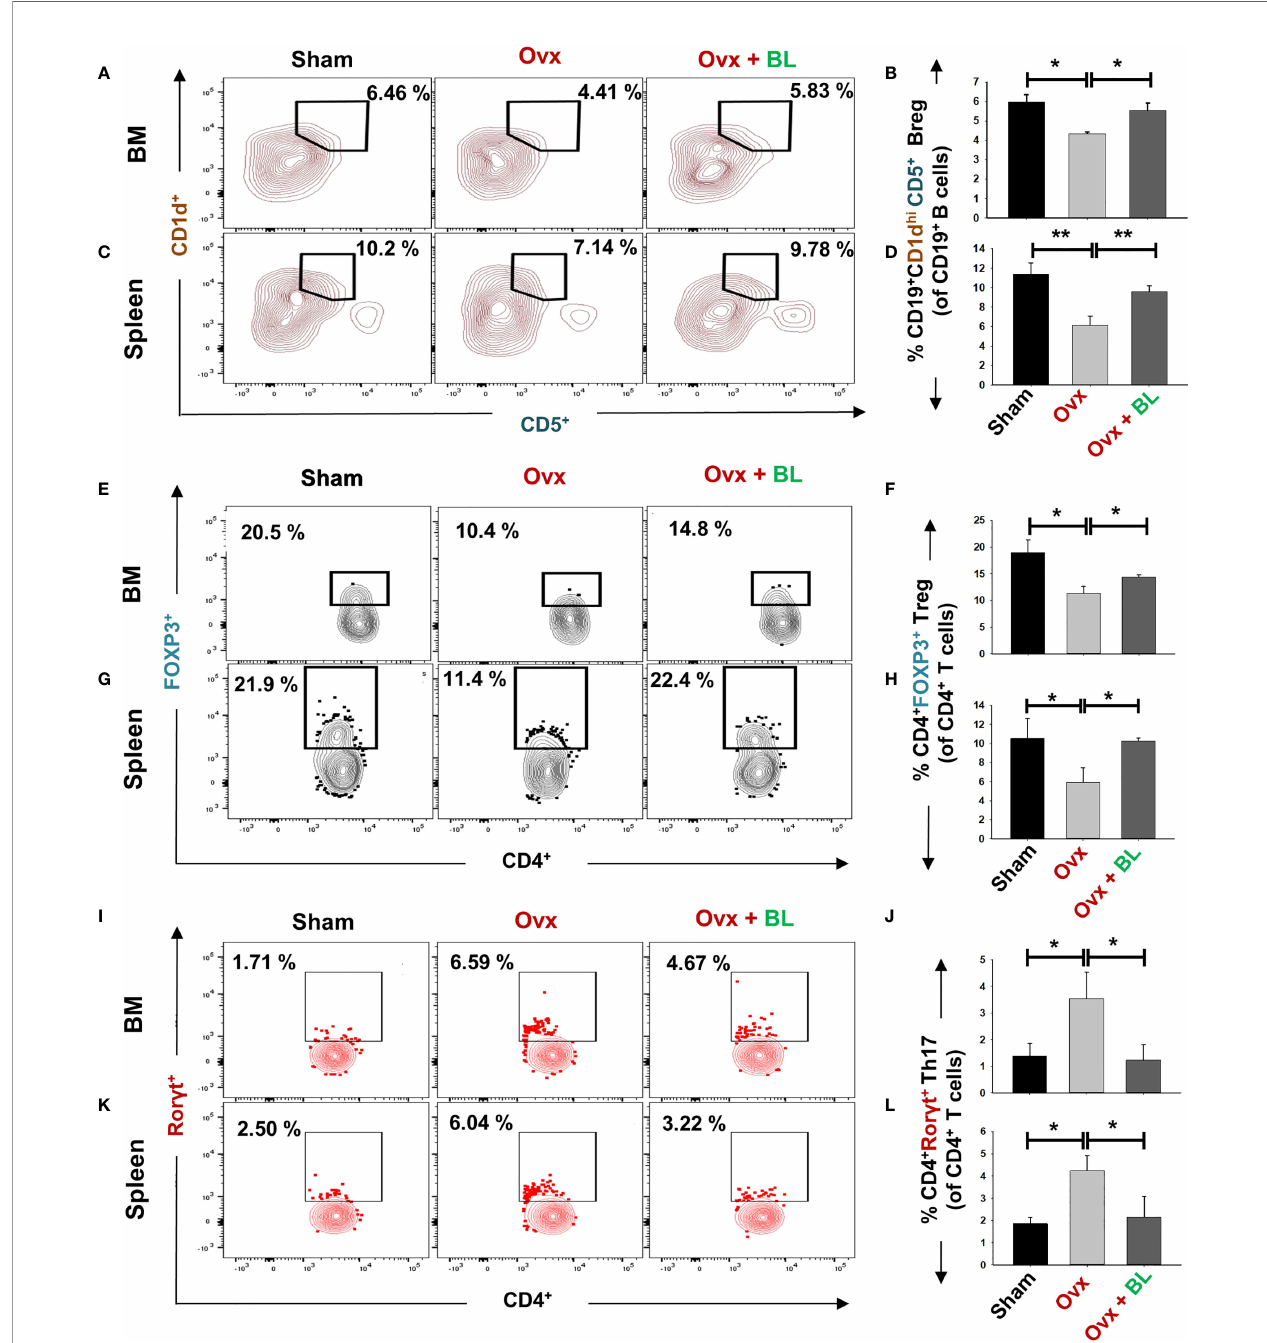
FIGURE 9 | BL administration modulates Breg, Tregs, and Th17 cells in vivo . Cells from various lymphoid organs were harvested and analyzed for Bregs and Tregs. (A) Contour plots representing the percentages of CD19 + CD1d hi CD5 + Bregs in BM. (B) Bar graphs representing the percentages of CD19 + CD1d hi CD5 + Bregs in BM. (C) Contour plots representing the percentages of CD19 + CD1d hi CD5 + Bregs in spleen. (D) Bar graphs representing the percentages of CD19 + CD1d hi CD5 + Bregs in spleen. (E) Contour plots represent percentages of CD4 + Foxp3 + Tregs in BM. (F) Bar graphs representing percentages of CD4 + Foxp3 + Tregs in BM. (G) Contour plots represent percentages of CD4 + Foxp3 + Tregs in spleen. (H) Bar graphs represent percentages of CD4 + Foxp3 + Tregs in spleen. (I) Contour plots represent percentages of CD4 + Ror g t + Th17 cells in BM. (J) Bar graphs representing percentages of CD4 + Ror g t + Th17 cells in BM. (K) Contour plots are representing percentages of CD4 + Ror g t + Th17 cells in spleen. (L) Bar graphs representing percentages of CD4 + Ror g t + Th17 cells in spleen. Data are reported as mean ± SEM. Similar results were obtained in two independent experiments with n = 6. Statistical signi fi cance of each parameter was assessed by ANOVA followed by paired group comparison. *p < 0.05, **p < 0.01 compared with indicated